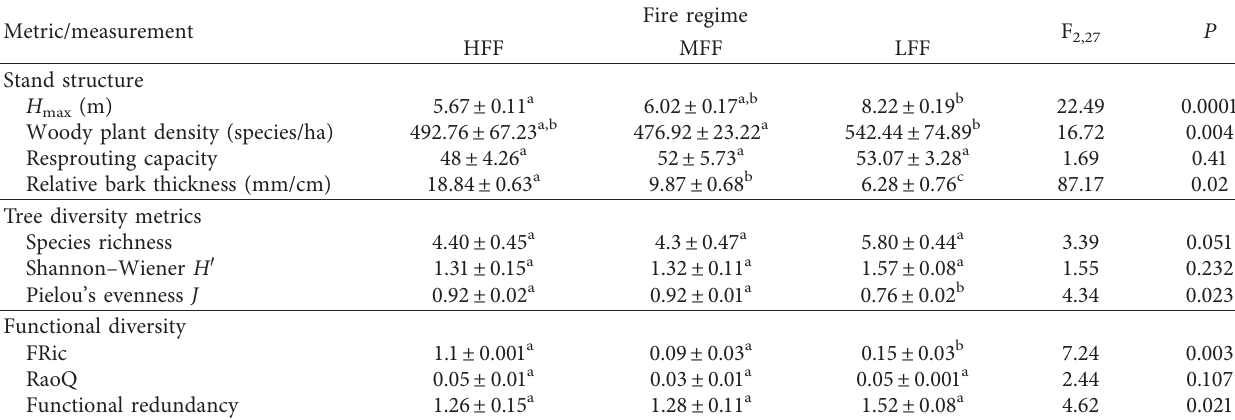
Table 3: Stand structure, diversity metrics, and functional diversity indices measured in high fire frequency (HFF), medium fire frequency (MFF), and low fire frequency (LFF) (mean ± standard